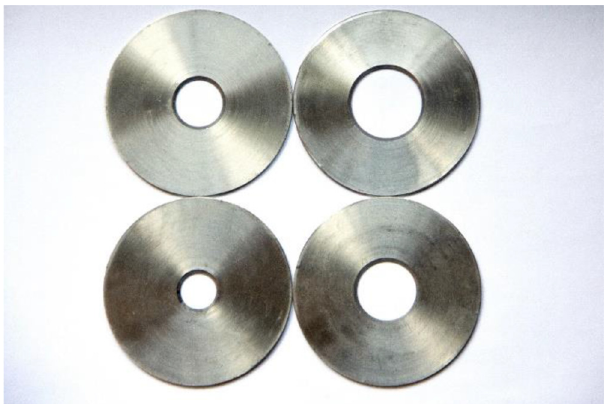
Fig. 3. Ori fi ces with 0.3, 0.4, 0.5 and 0.6 contraction ratio ( b ). Fig. 4. The geometric shape of (a) a single-hole ori